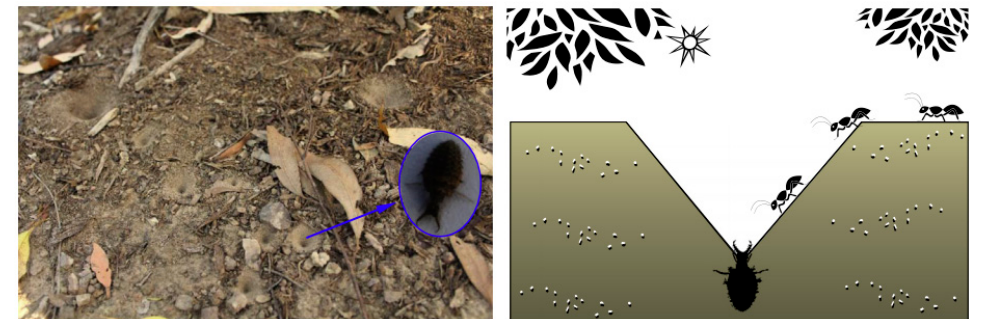
Figure 2. Ant-lions (shown with blue arrow), ants, and the hunting behavior, which are inspiration sources for the ant-lion optimizer (ALO) algorithm [6] (the figures are free to use according to the permission policies of Inderscience, publisher of the referenced article).